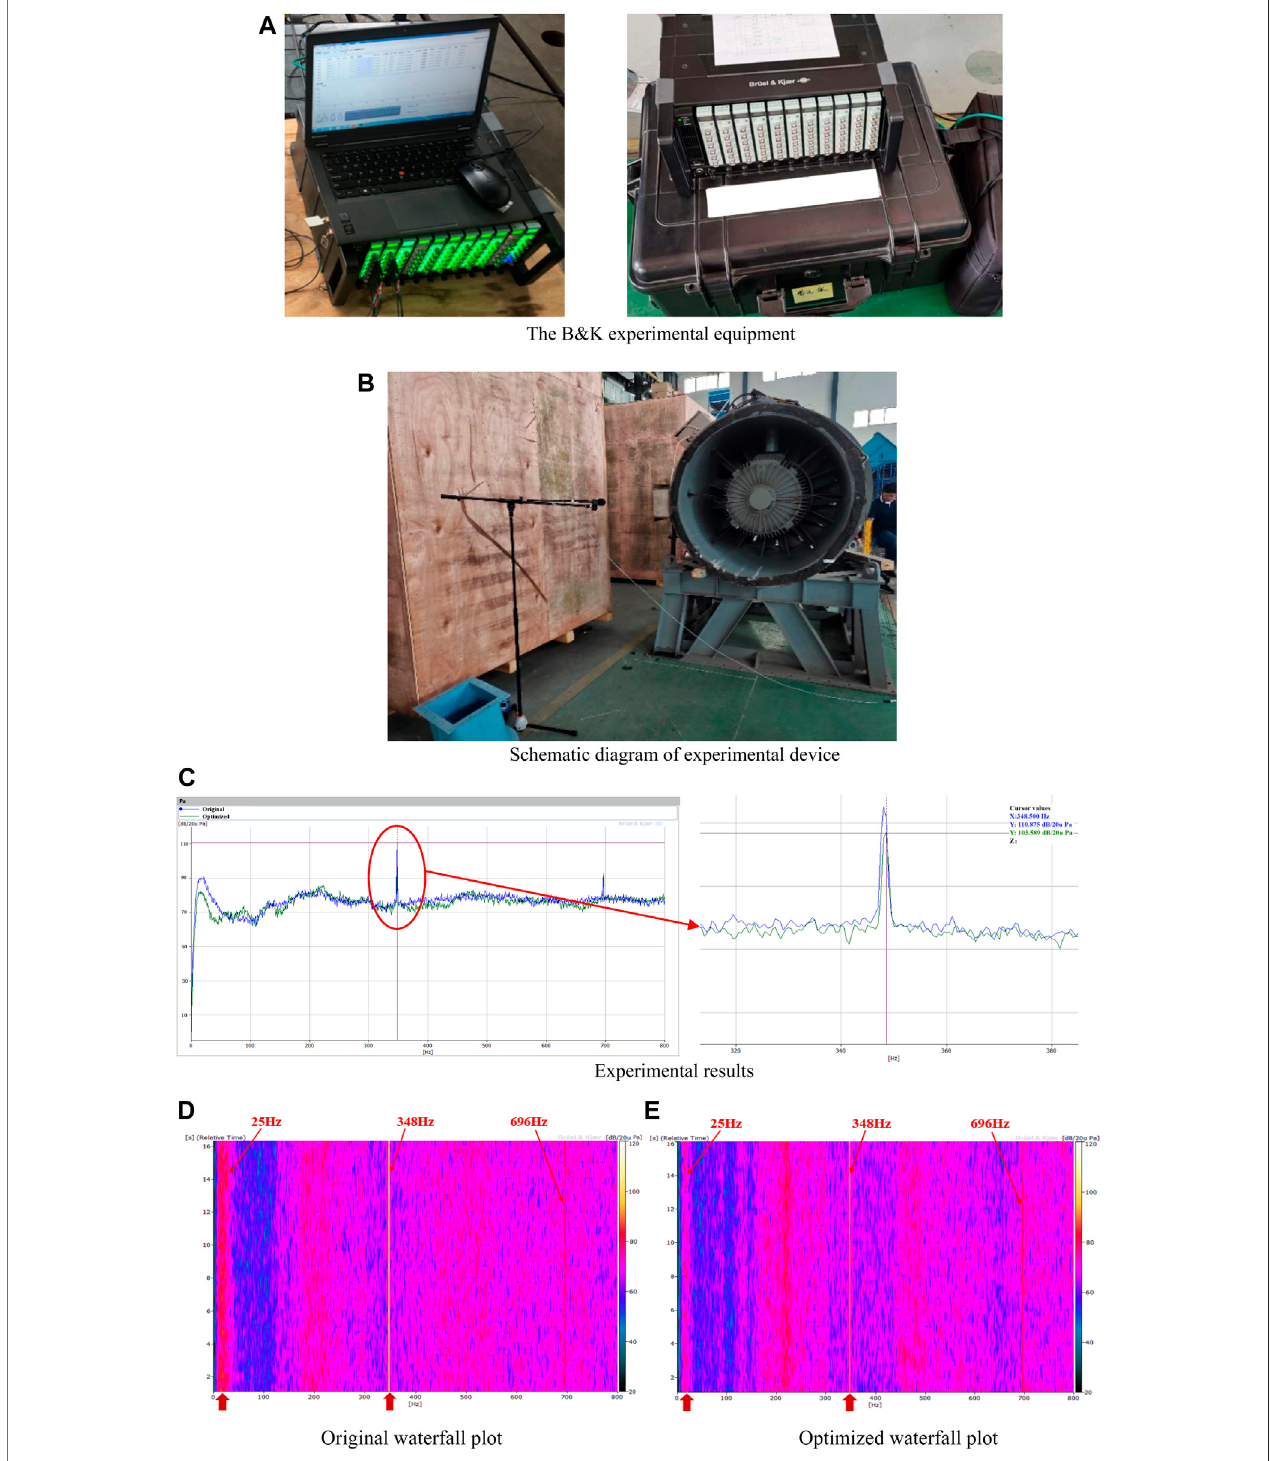
FIGURE12 | Noise experimental results. (A) The B&Kexperimental equipment (B) Schematic diagram ofexperimental device (C) Experimental results (D) Original waterfall plot (E) Optimized waterfall plot.